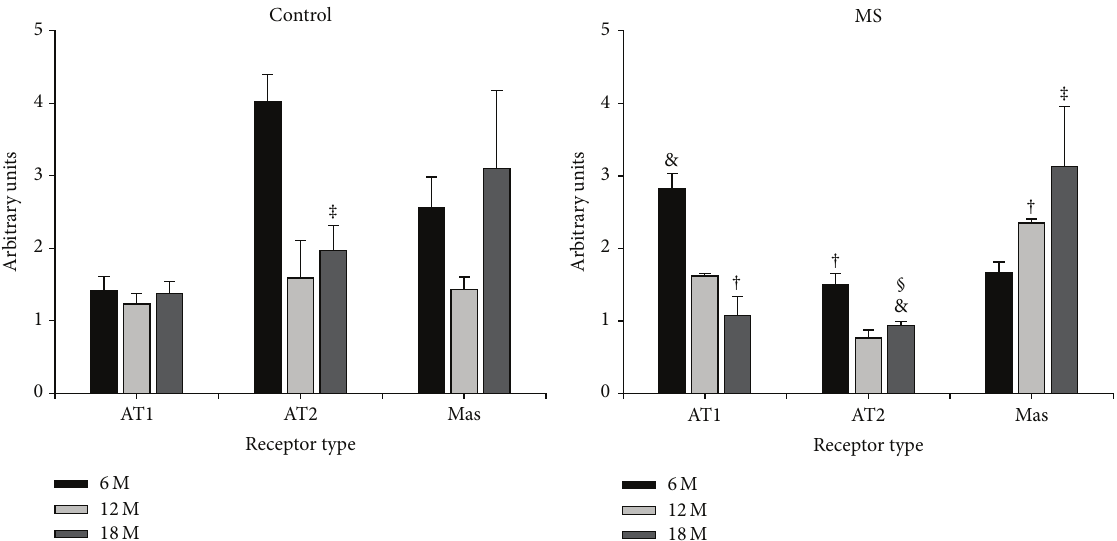
Figure 6: Quantitative analysis (receptor type fluorescence versus relative fluorescence) for AT1, AT2, and Mas receptors in aortas of control and MS rats during aging measured from the immunohistochemistry images in Figures 3, 4, and 5. Details of the technique are described in Section 2. Values represent mean ± SEM of six different experiments. & 𝑃 < 0.05 against C; † 𝑃 < 0.01 against C; ‡ 𝑃 < 0.05 against other ages; § 𝑃 < 0.05 against 6